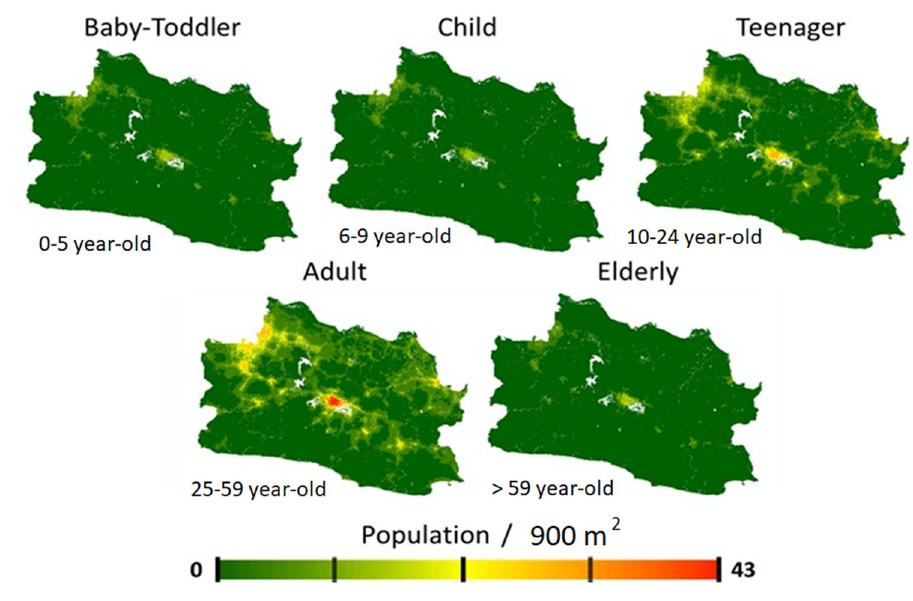
Figure 5. Distribution of population density based on age group.